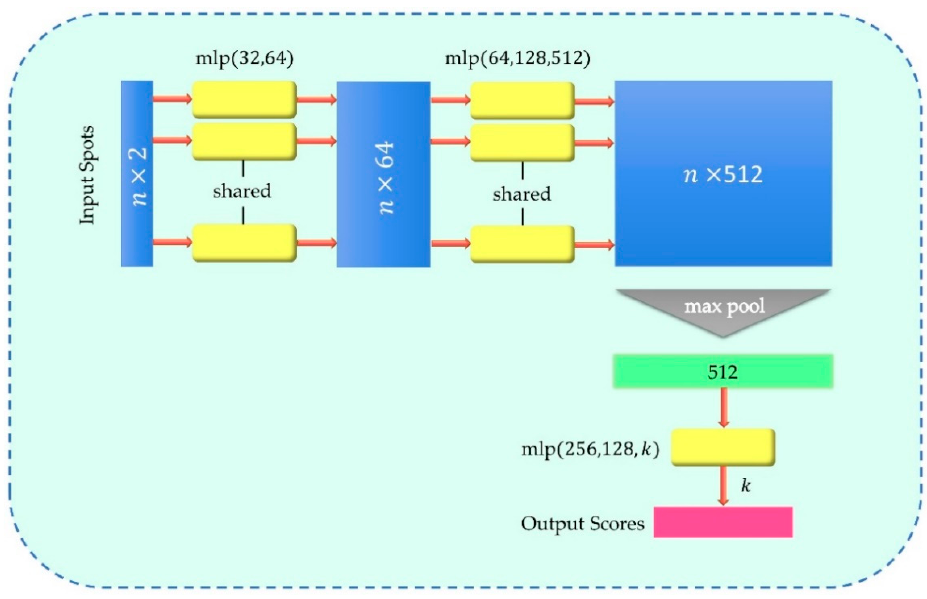
Figure 4. Spot-matching neural network structure.